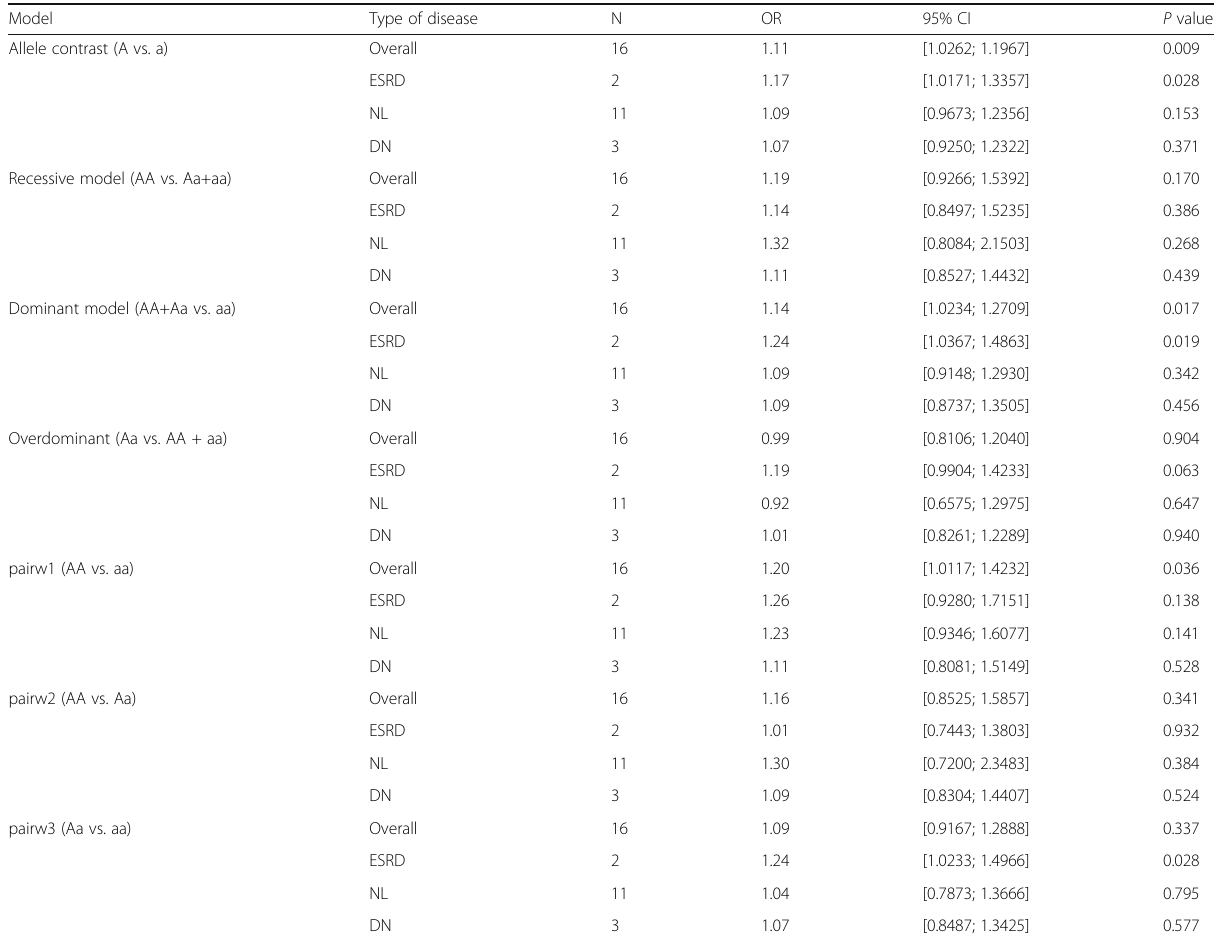
Table 2 Subgroup analysis showing disease-specific risk with VDR TaqI polymorphism